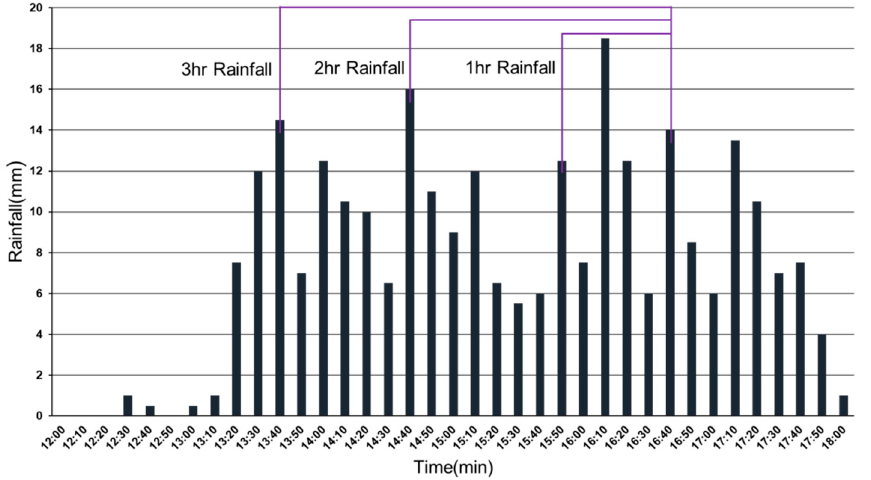
Figure 8. Automatic Weather System (AWS) in Gangnam District (September 21, 2010).